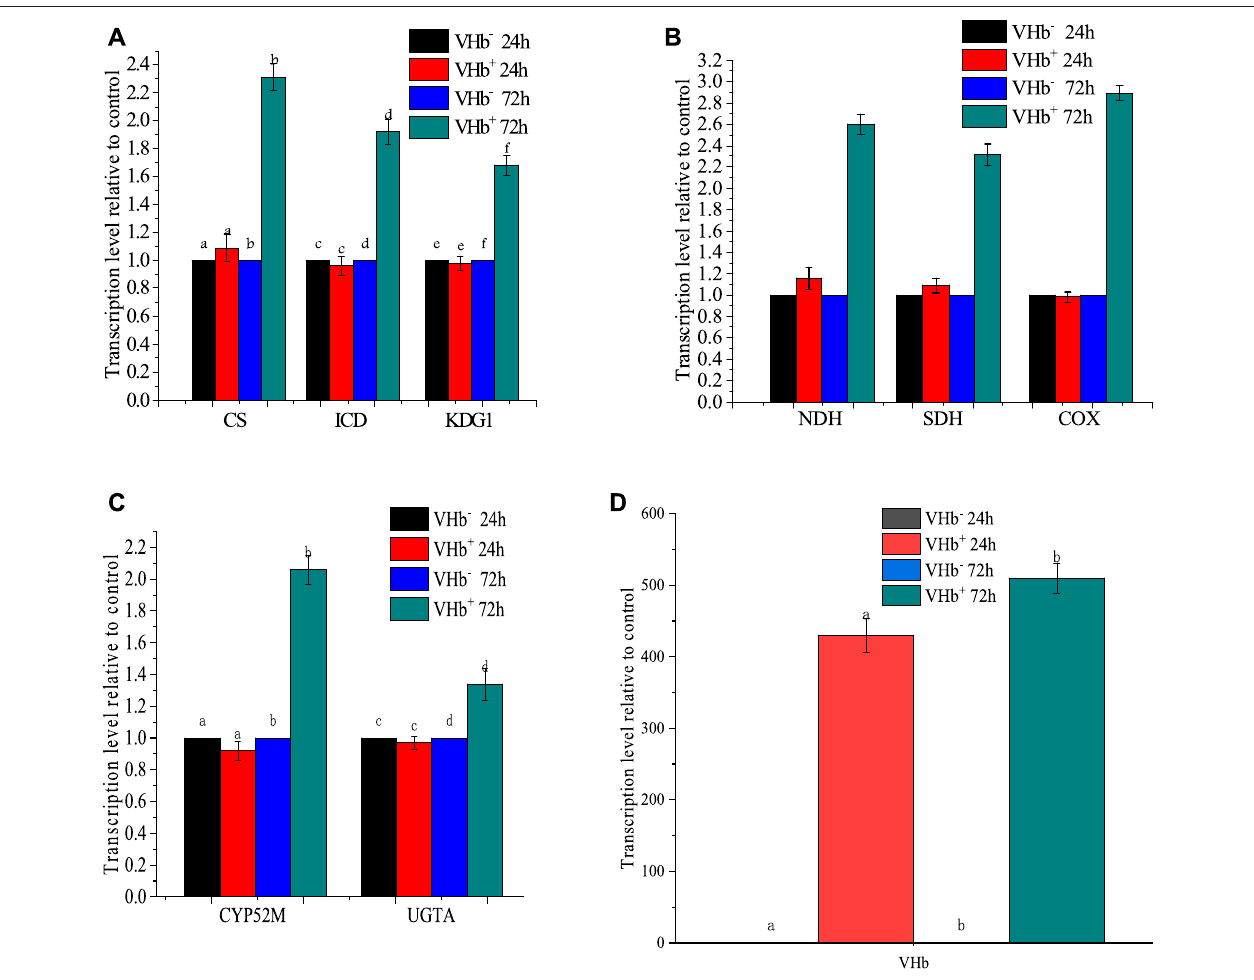
FIGURE 6 | Transcription levels of key genes involved in the TCA cycle, respiratory chain and sophorolipid biosynthesis at 24 and 72 h of fermentation. The transcription levels ofgenesin therecombinant strains were normalized tothe transcription level of genesin the wild-type strains. (A) transcription levels of CS , ICD , and KDG1 ; (B) transcription levels of NDH , SDH , and COX ; (C) transcription levels of CYP52M and UGTA ; and (D) expression level of